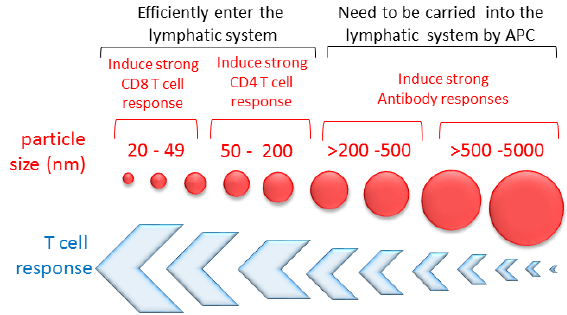
Figure 3. Effect of the particle size on the immune response. Particles 20–200 nm in diameter efficiently enter the lymphatic system, with particles smaller than 50 nm being more efficiently transported than those larger than 100 nm. Particles smaller than 49 nm in diameter induce a stronger T CD8 cell